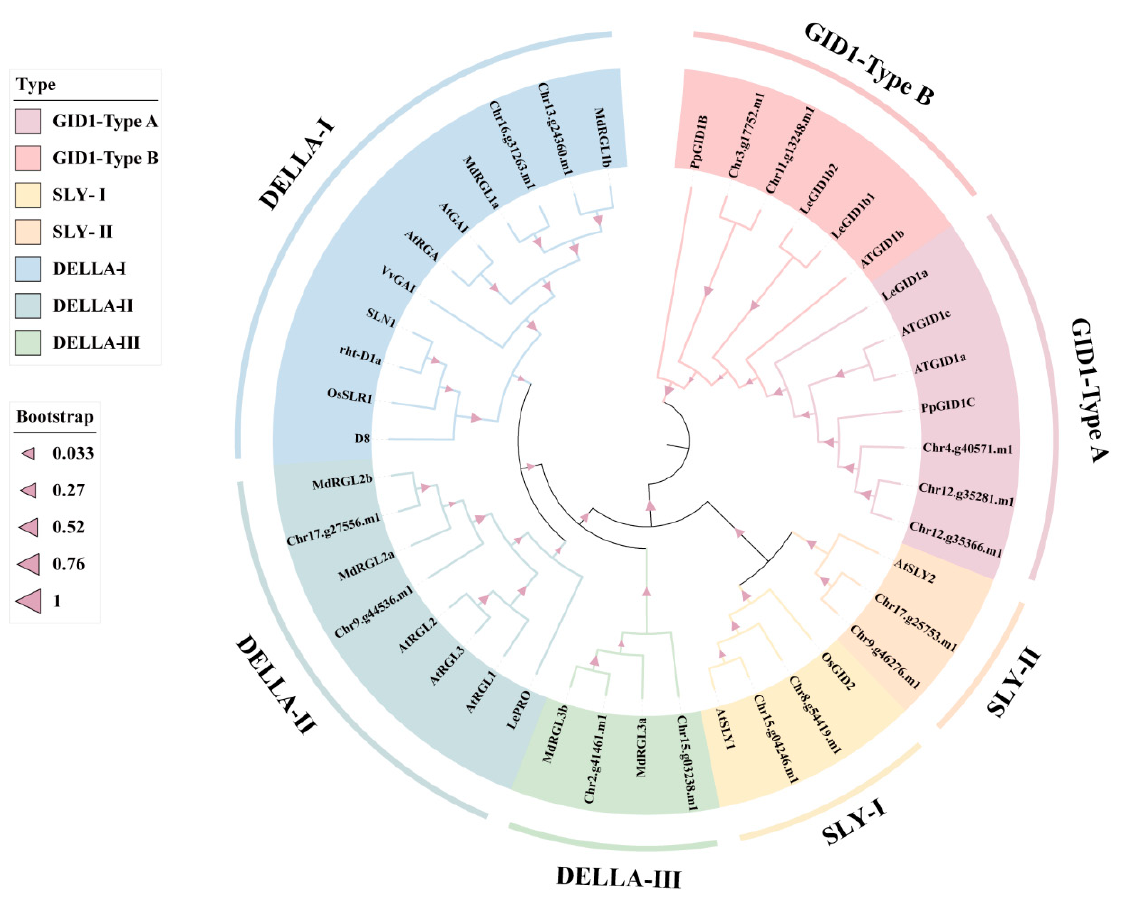
Figure 2. Phylogenetic tree of PbGID1s, PbDELLAs, and PbSLYs of ‘duli’ pear ( Pyrus betulifolia Bunge). Multiple sequence alignment was performed using the encoded protein sequences of the candidate genes with Clustal software. MEGA 6.0 was applied to construct the maximum likelihood (ML) tree using the JTT matrix model with 1000 bootstrap replicates. The different groups of PbGID1s, PbDELLAs, and PbSLYs are color ‐ coded as indicated on the top left panel.